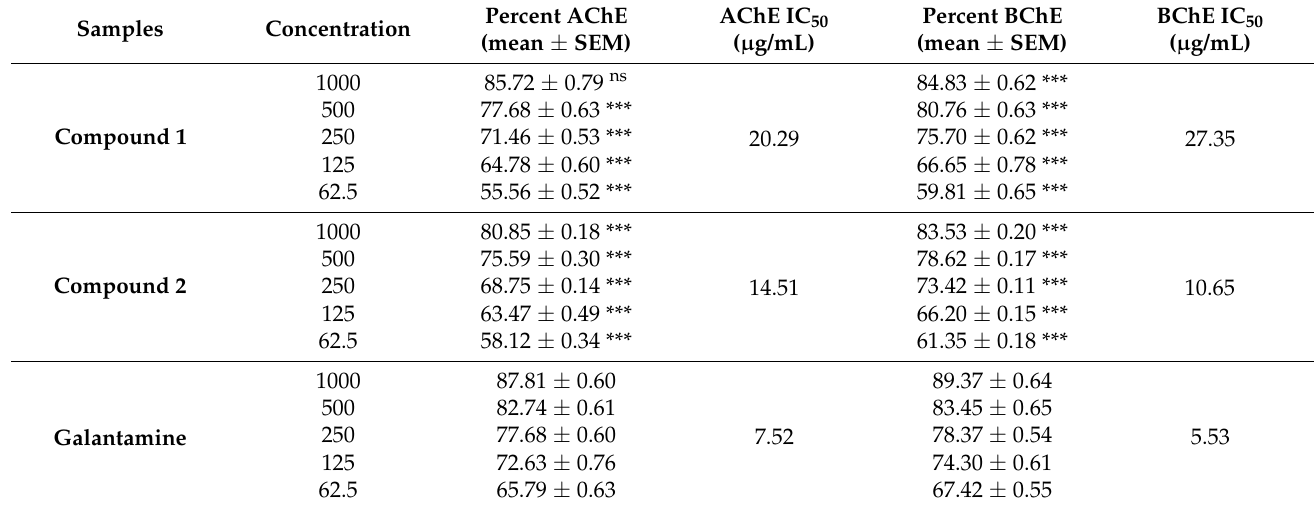
Table 1. Anticholinesterase results of the isolated phytosteroids in comparison to galantamine.